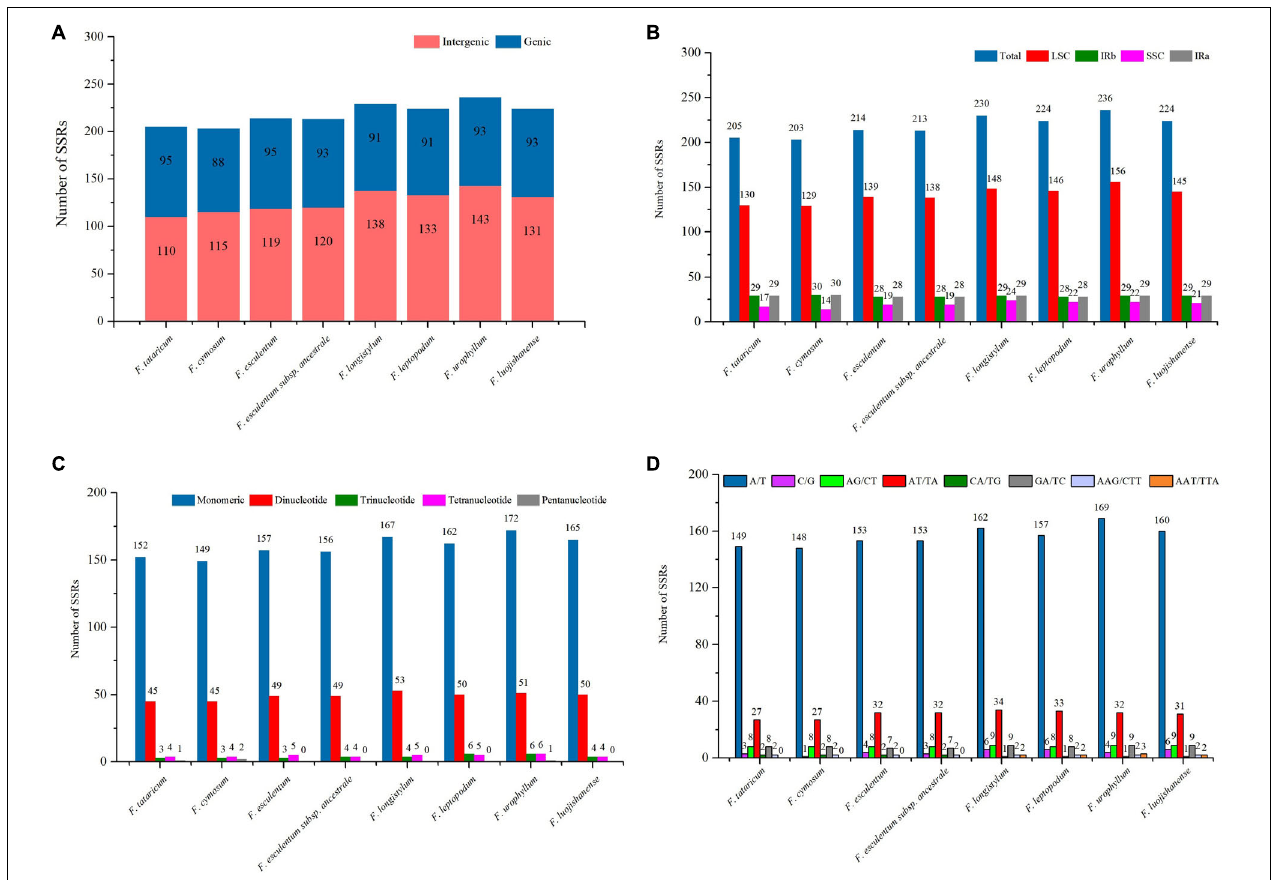
FIGURE 6 | Analysis of SSRs in the eight Fagopyrum species cp genomes. (A) Distribution of SSRs in genic and intergenic. (B) Distribution of SSRs in LSC, IRa/IRb, and SSC. (C) The number of different SSR types detected in the eight Fagopyrum species cp genomes. (D) The number of different base SSR types in the eight Fagopyrum species cp genomes.